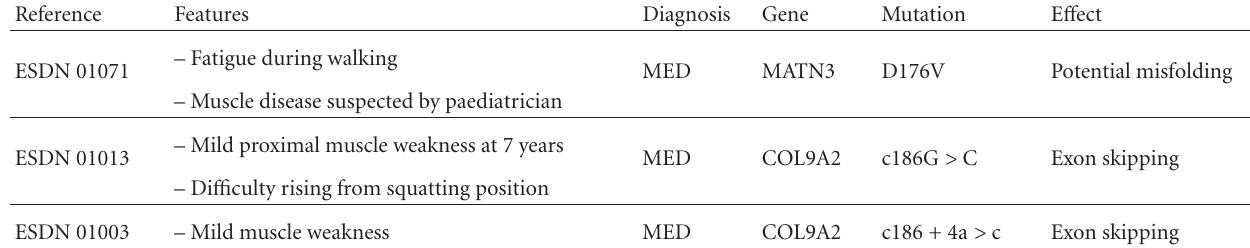
Table 2: Patient and mutation data were obtained from the European Skeletal Dysplasia Network (ESDN reference numbers) or recent publications, as